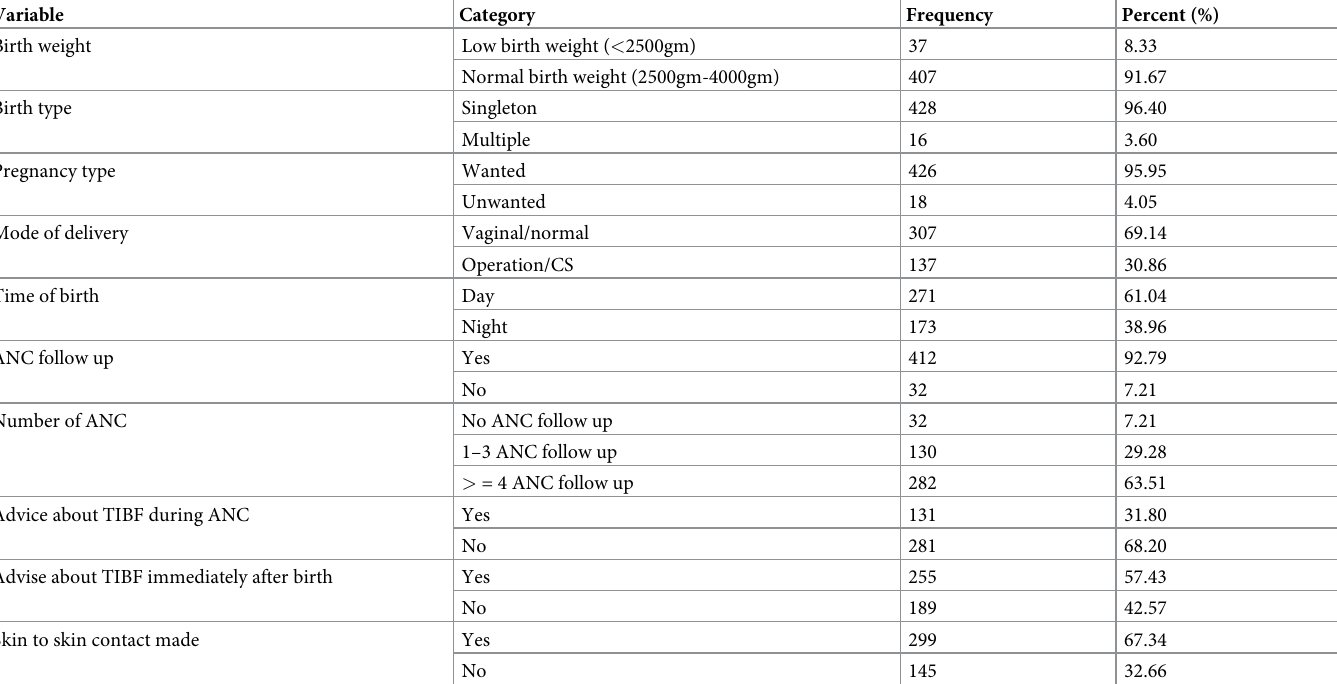
Table 3. Obstetric and health service related characteristics of postnatal mothers within 12 hours of postpartum in Debre Markos Comprehensive Specialized Hos- pital, North West, Ethiopia, 2020.